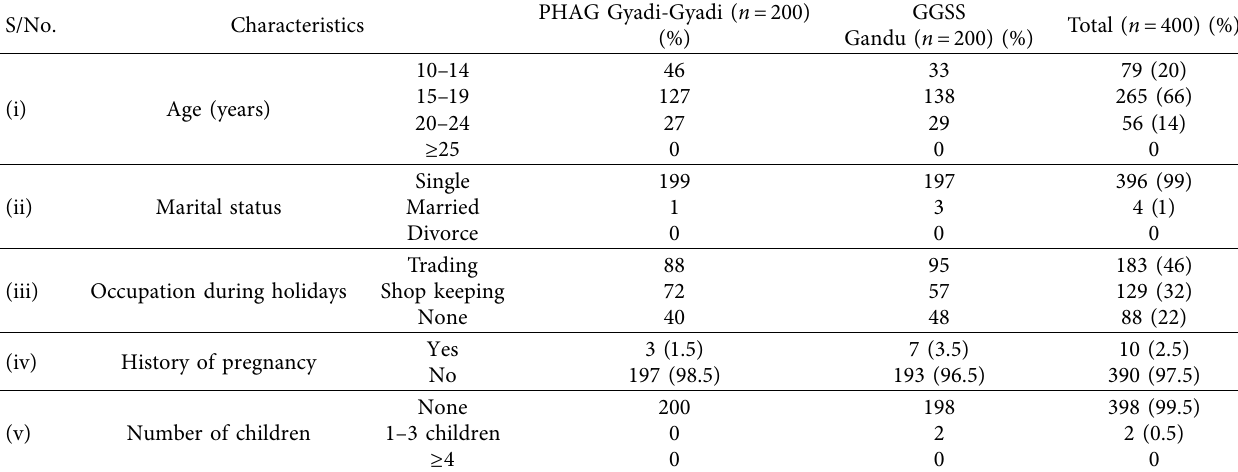
Table 3: Demographic characteristics that may be linked to the occurrence of HPV among the respondents.